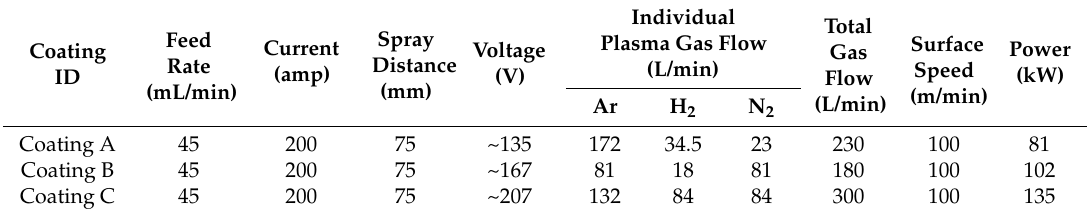
Figure 1. A schematic illustration of the axial plasma spraying of an 8 wt.% yttria-stabilized-zirconia-graphene oxide (8YSZ-GO) suspension. Table 1. The spray parameters used to deposit the 8 wt.% yttria-stabilized-zirconia-graphene oxide (8YSZ-GO) coatings.